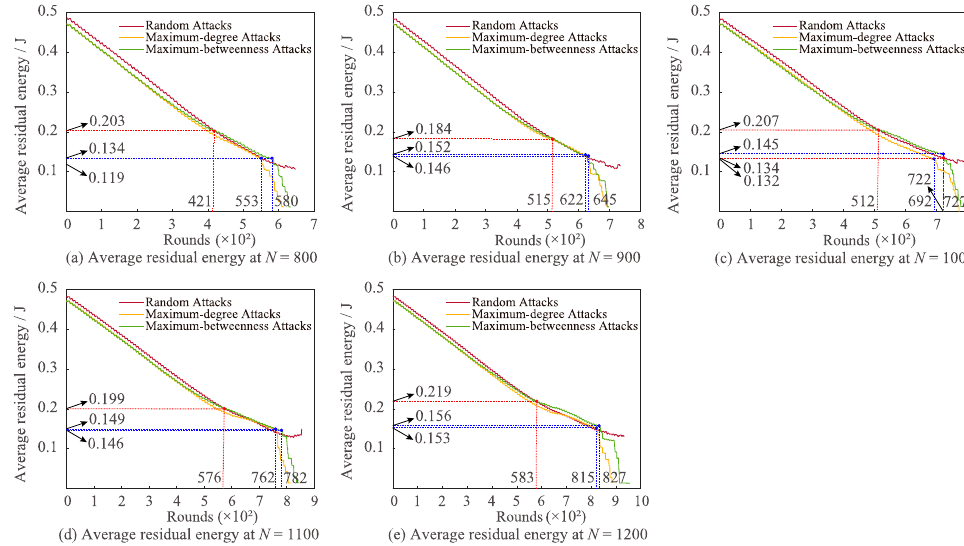
Figure 9. Influences of varying N on average residual energy for different attacks.